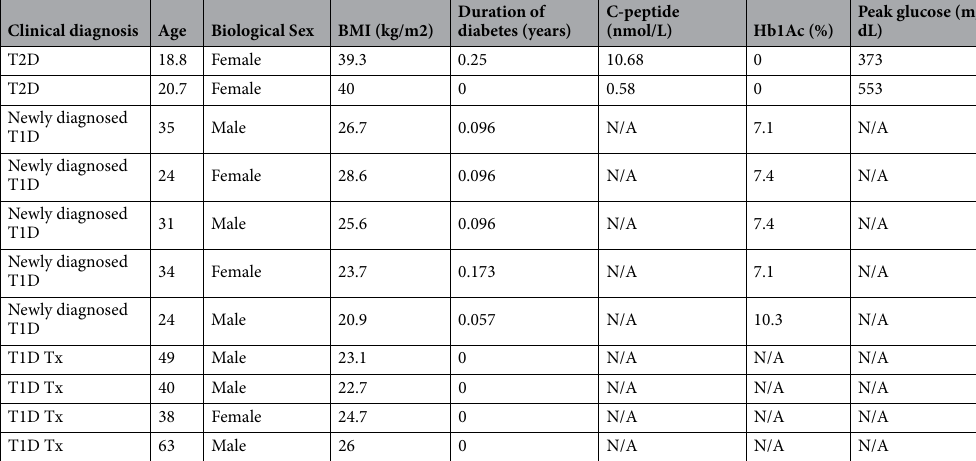
Table 1. Demographics and clinical status of the pancreas donors used in the Affymetrix analysis. “T1D” describes donors with recent (median disease duration, 5.0 years) disease, “Newly diagnosed T1D” donors which were diagnosed with a median of 35 days prior to pancreas donation, “T1D Tx” biopsies from donors with recurrent T1D, “AB + ” autoantibody-positive but not clinically diagnosed donors, “T2D” donors with T2D. “Peak glucose” is the highest measurement taken at the hospital. “N/A” indicates that the given attribute has not been measured.